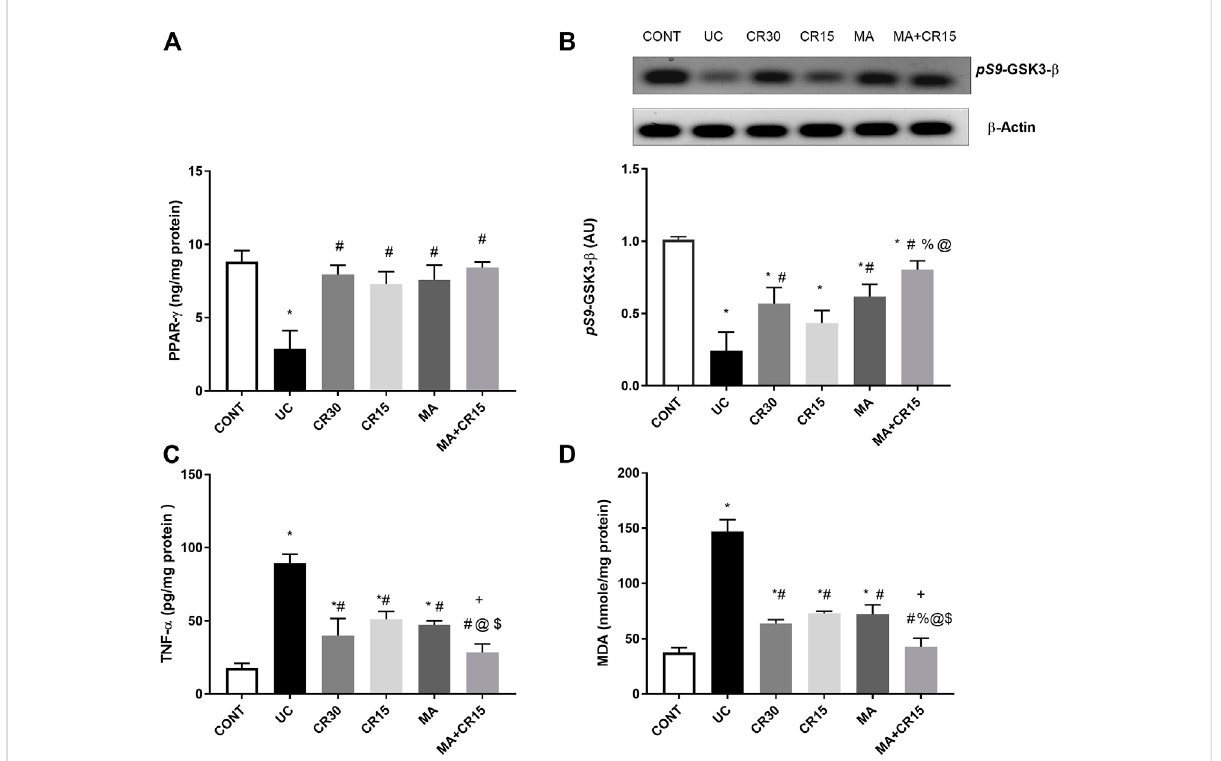
FIGURE 6 Effect ofmirabegronand/orcarvedilol oncolonproteinexpression/content of (A) PPAR- γ , (B) p (S9) -GSK3- β , (C) TNF- α ,and (D) MDA inratswith IAA-induced ulcerative colitis. Data are presented as mean ± SD (n = 4 – 6). Statistical analysis was carried out using one-way ANOVA followed by Tukey ’ s post-hoc test; p < 0.05. As compared to the (*) CONT, (#) UC, (%) CR30, (@) CR15, and ($) MA groups. (+) indicate additive interaction using CDI. CDI, coef fi cient of drug interaction; CONT, control; CR, carvedilol; GSK3- β , glycogen synthase kinase 3 beta; IAA, iodoacetamide; MA, mirabegron; MDA, malondialdehyde; PPAR- γ , peroxisome proliferator-activated receptor gamma; TNF- α , tumor necrosis factor-alpha; UC, ulcerative